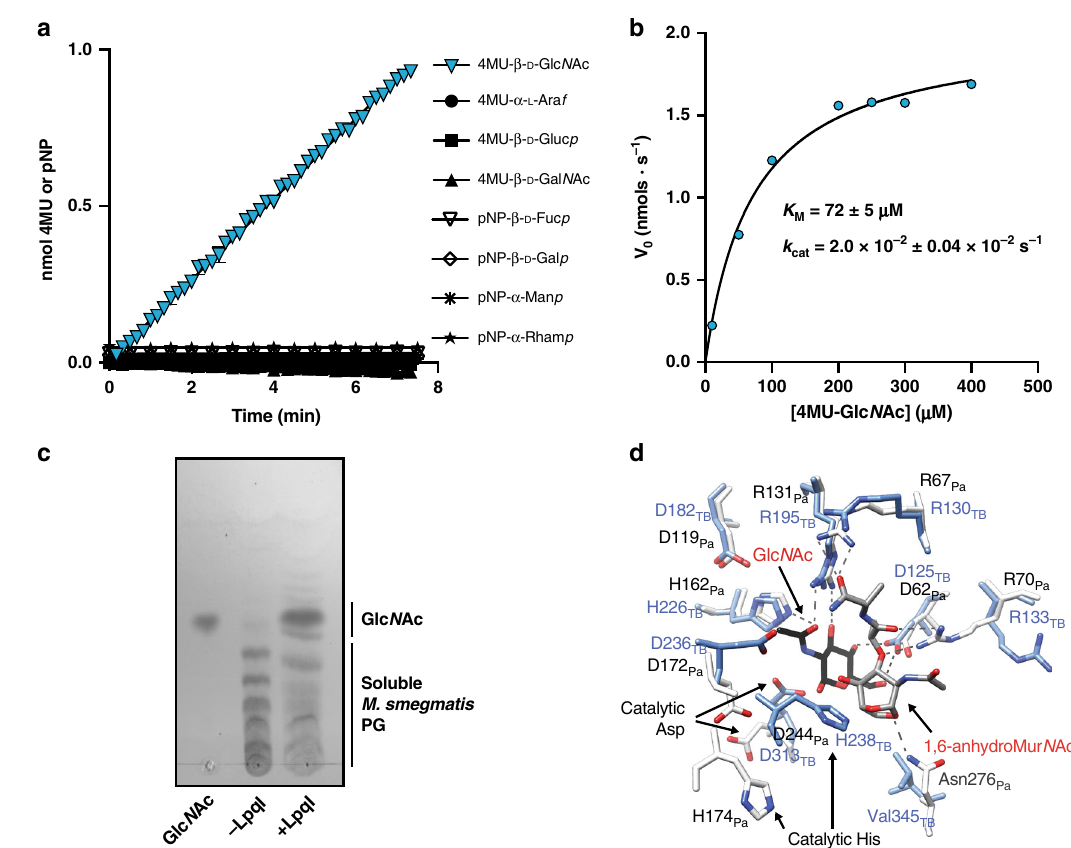
Fig. 2 LpqI is an authentic NagZ-type enzyme. a Reactions including 1 μ M LpqI and the indicated chromogenic substrates at 1 mM were incubated at 37 °C and release of p NP or 4MU was followed by absorbance or fl uorescence respectively. Cleaveage of 4MU-Glc N Ac is indicated by blue triangles. b LpqI was incubated with increasing concentrations of 4MU-Glc N Ac. The rate of 4MU release was plotted and the curve fi t with the Michaelis – Menton equation using GraphPad Prism 7.0. ( n = 3, error bars are ± SD). c Thin-layer chromatograph of reaction products showing that LpqI is able to release Glc N Ac from soluble muropeptides derived from M. smegmatis mc 2 155 PG. d The active site of LpqI is highly conserved as evidenced by the similar positioning of key binding residues observed in the Glc N Ac, 1,6-anhydroMur N Ac complex with NagZ Pa (PDB: 5G3R) the main chains of which have been aligned with an RMSD of 2.3 Å using LSQ KAB